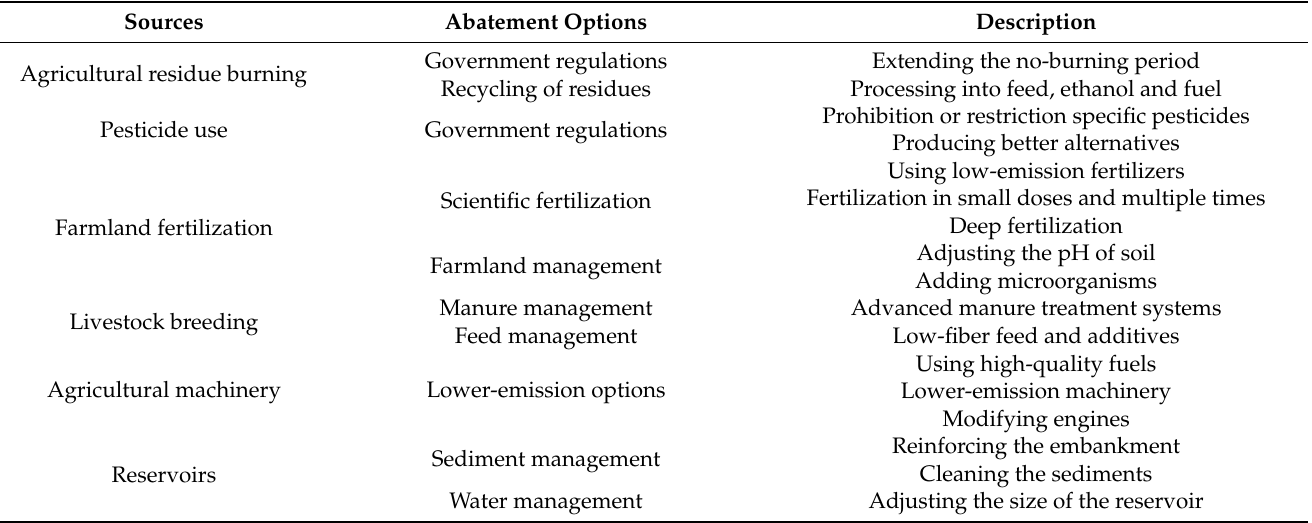
Table 2. Summary of emission reduction